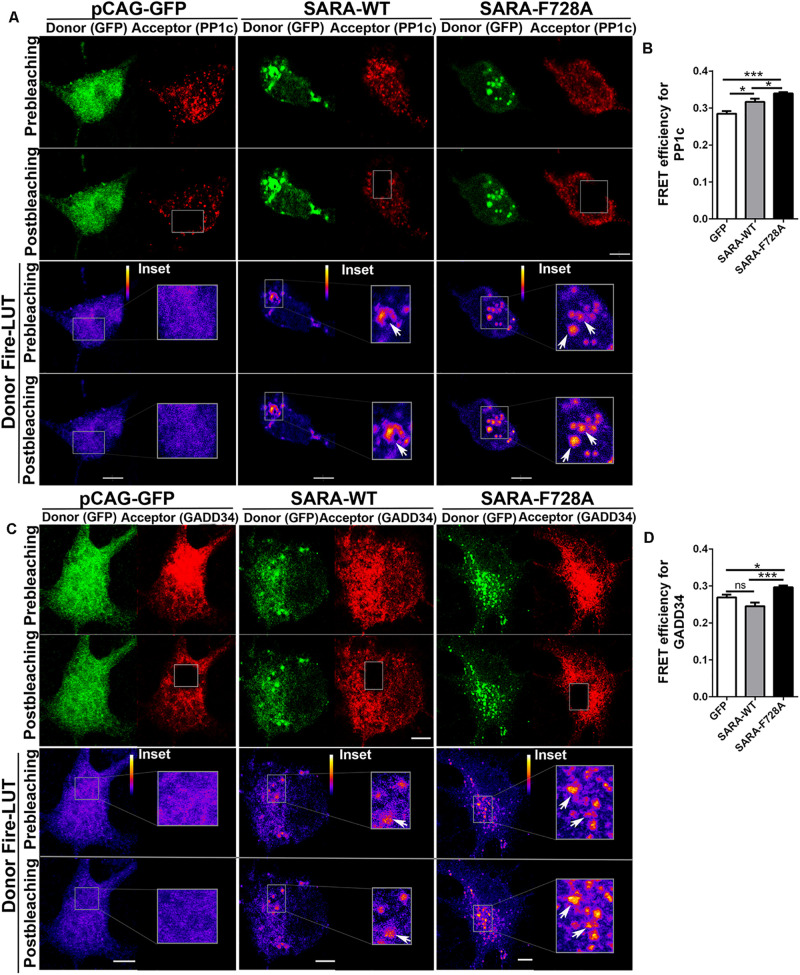
Local recruitment of PP1c and GADD34 by SARA at endosomes in developing hippocampal neurons. Neurons were transfected with GFP, SARA-WT-GFP, or SARA-F728A-GFP after plating and fixed at 2 DIV to analyze the interaction between SARA and PP1c and GADD34 at EEs by Acceptor Photobleaching-FRET. (A,C) Representative images of neurons transfected with GFP, SARA-WT-GFP, or SARA-F728A-GFP (green channel, donor) and immunostained for PP1c (red cannel, acceptor, A) or GADD34 (red channel, acceptor, C). Rectangles show the region bleached in the soma (magnification of these regions are shown as insets). Arrows show local interaction between SARA and TβRI at endosome. (B,D) Quantification of FRET efficiency for PP1c (B) and GADD34 (D). *p < 0.05, **p < 0.005, ***p < 0.001 vs control (white column), ns: non-significant, ANOVA, Dunnett’s post-test (15 neurons were analyzed by condition). Results represent the mean of three independent cultures (n = 3). Scale bar: 20 μm; FRET Scale bar: 5 μm.